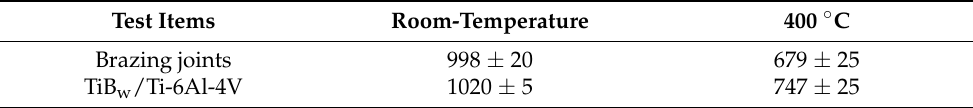
Table 3. Result of tensile strength test at room-temperature and 400 ◦ C